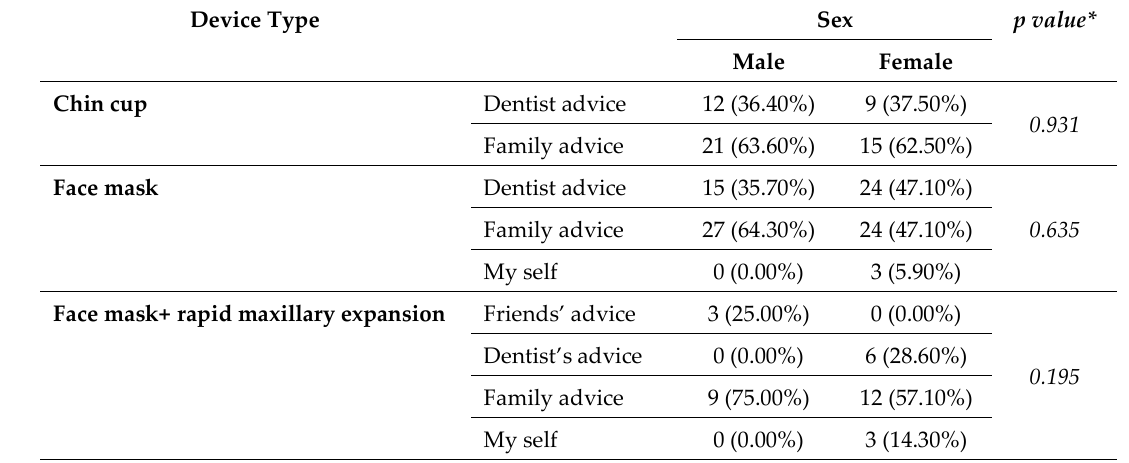
Table 6 : People who influence the treatment decision by device type